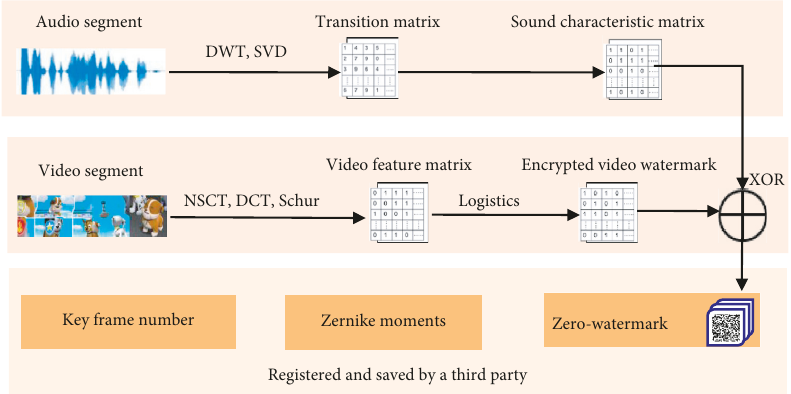
Figure 2: Zero-watermark generation process based on audio and video features.